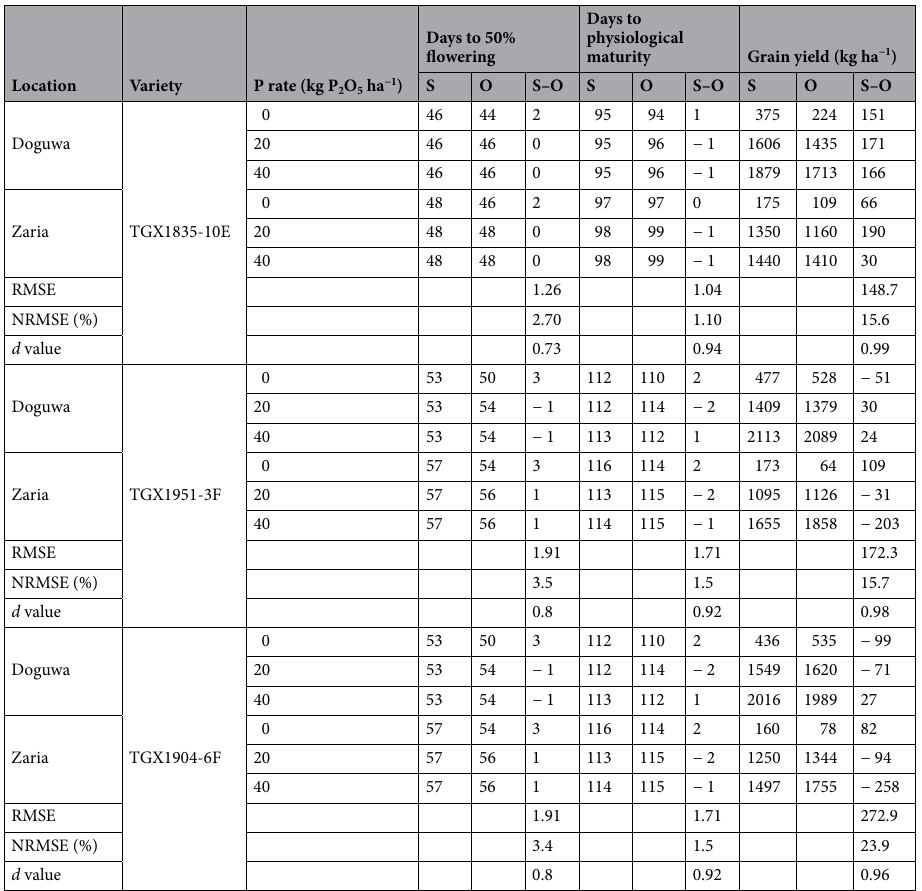
Table 4. Simulated (S) and observed (O) days to 50% flowering, physiological maturity and grain yield obtained from evaluation experiments conducted at two locations in Doguwa and Zaria. d -Willmott index of agreement, (Willmott, 1982) ranging from 0 to 1, 1 being perfect agreement.